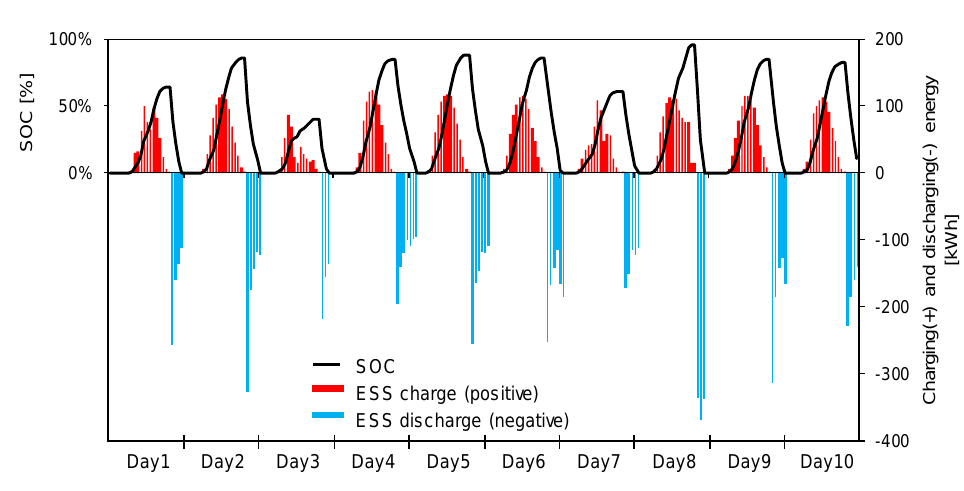
Figure 2. Self-consumption ESS schedule in mode 1.